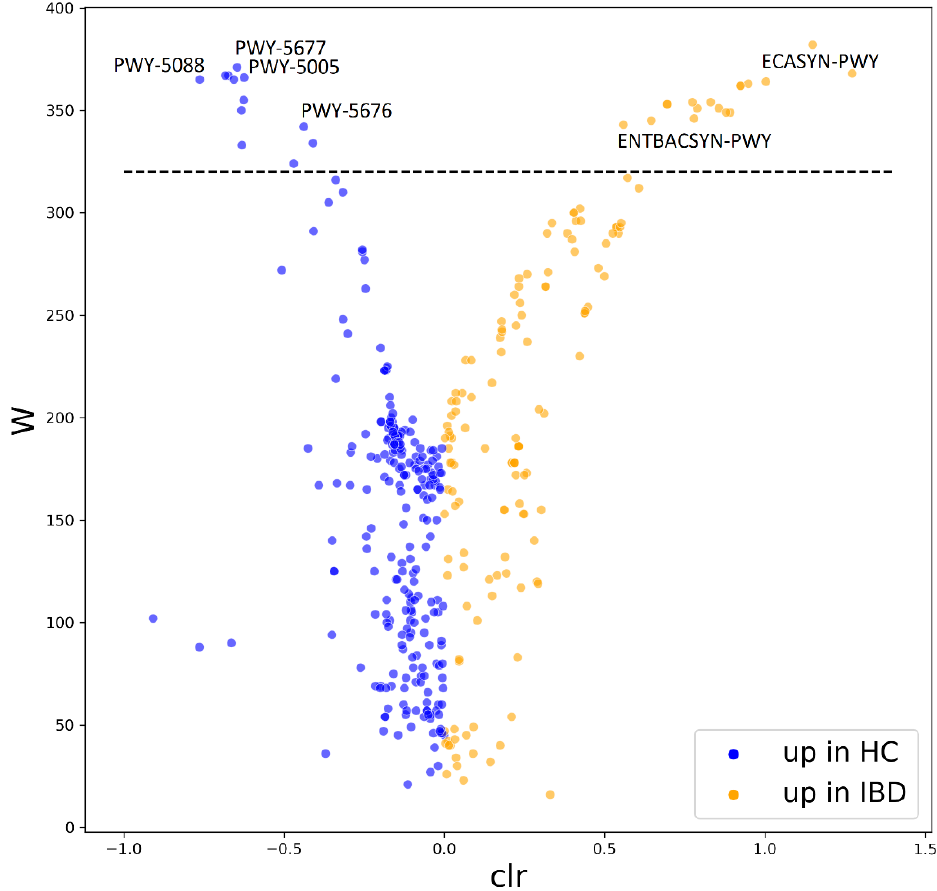
Figure 7. Differentially abundant pathways reconstructed from 16S rRNA data by PICRUST2. The volcano plot shows the differentially abundant pathways between healthy controls and patients with IBD as determined by ANCOM. Each dot represents a pathway entry from the MetaCyc database, which was reconstructed from 16S rRNA data. Pathways increased in HC are blue, pathways increased in IBD are orange. The dashed line indicates the W-statistic cut-off value. The full list of the differentially abundant features can be found in Table S2. Abbreviations: HC, healthy controls; IBD, patients with inflammatory bowel disease; W, W-statistic; clr, centered log ratio; PWY-5677, succinate fermentation to butanoate; PWY-5005, biotin biosynthesis; PWY-5088, L-glutamate degradation to propionate; PWY-5676, acetyl-CoA fermentation to butanoate; ECASYN-PWY, enterobacterial common antigen biosynthesis; ENTBACSYN-PWY, enterobactin biosynthesis.